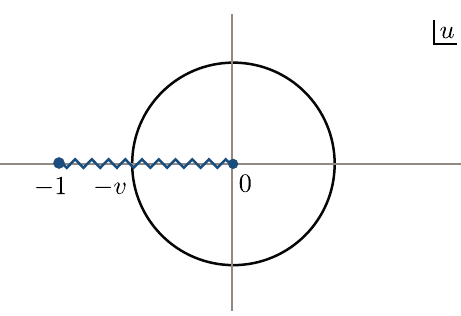
Figure 5. Illustration of the analytic structure of the function ^ F ( u; v